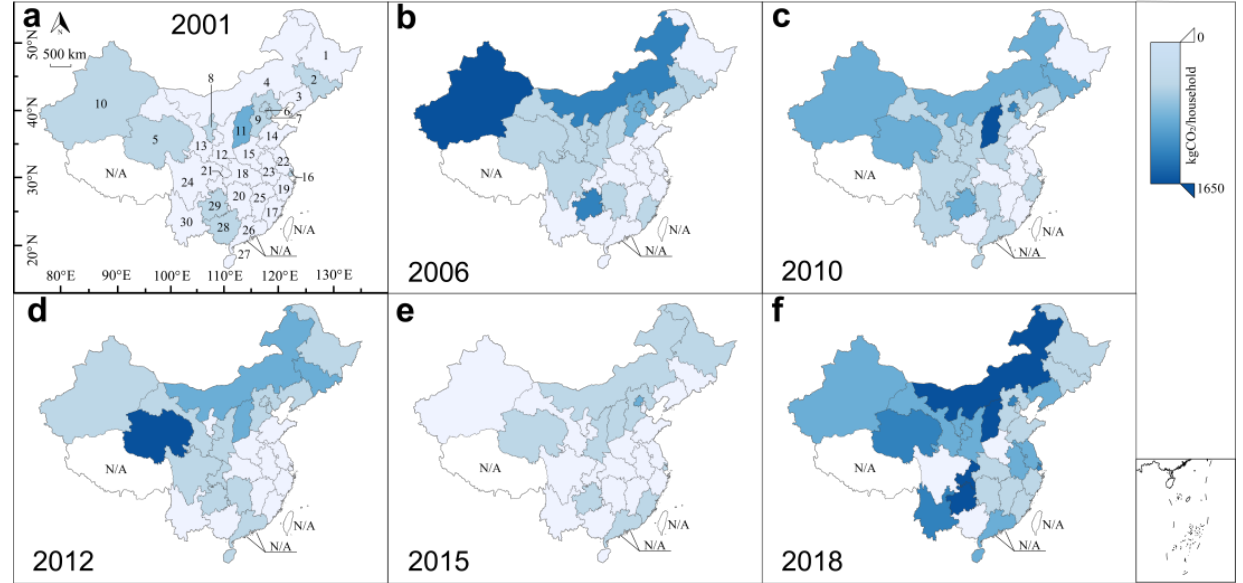
Figure 2. Changes in the carbon mitigation intensity of residential buildings by province. Note: the numbers indicate the names of the provinces which can be found in Appendix A. Based on the review of carbon mitigation strategies for residential buildings in China, various observation years were selected from 2001 to 2018, as detailed in Appendix B. ( a ) The carbon mitigation intensity of residential buildings in 2001, ( b ) 2006, ( c ) 2010, ( d ) 2012, ( e ) 2015, ( f ) 2018. North China and Northeast China showed high carbon mitigation intensity during the study period, with an annual carbon mitigation intensity of 602.7 kg of carbon dioxide per household (kgCO 2 /household) and 376.9 kgCO 2 /household on average, respectively. Before 2010, high value clusters were mainly located in North China and Northeast China. After 2010, carbon mitigation intensity began to decrease and the total carbon mitiga- tions between provinces were closer. From 2017, carbon mitigation intensity began to pick up and even exceed the peak that occurred around 2009. Around 2018, the high-value clus- ters of carbon mitigation intensity were mostly concentrated in North and Southwest